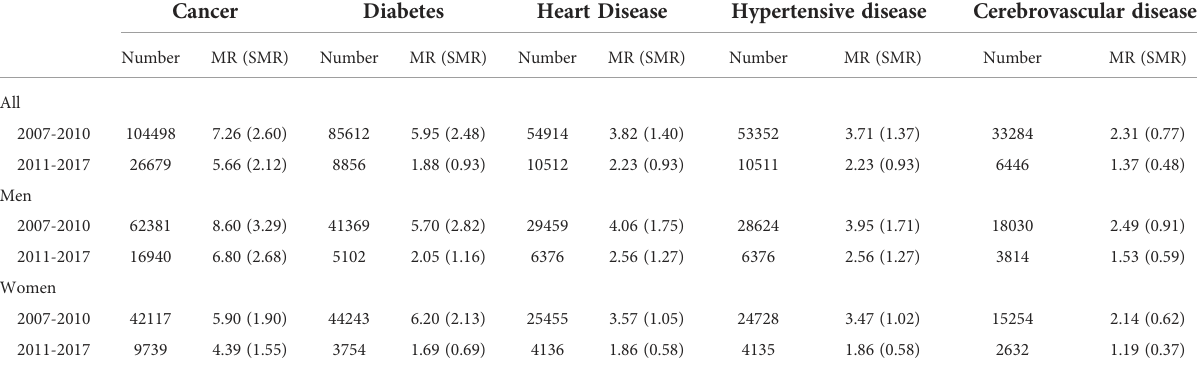
TABLE 4 Major causes of death in patients with diabetes by year of diabetes diagnosis (2007-2010 versus 2011-2017, follow up to the end of 2018). Cancer Diabetes Heart Disease Hypertensive disease Cerebrovascular